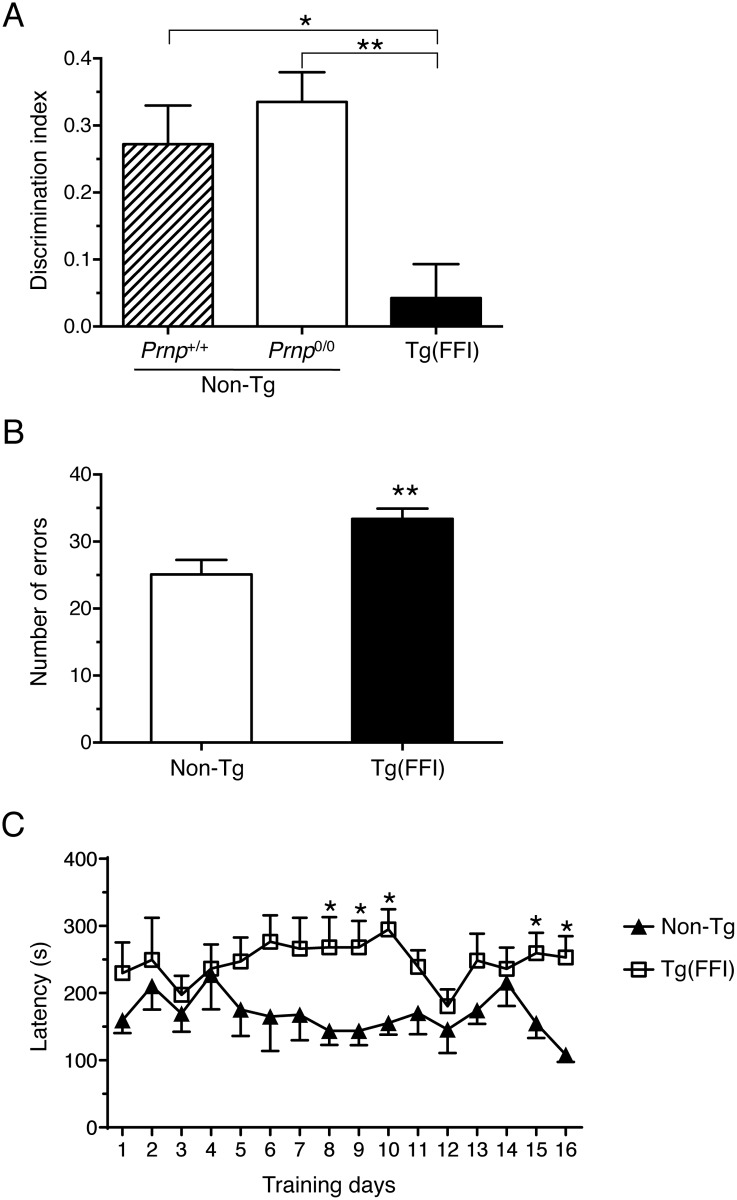
Tg(FFI) mice show recognition and spatial working memory impairment.(A) Performance in the novel object recognition task was expressed as a discrimination index (see Experimental Procedures). Histograms indicate the mean ± SEM of 10 non-Tg/Prnp
+/+, 10 non-Tg/Prnp
0/0, and 8 Tg(FFI-26+/-)/Prnp
0/0 aged 70 days; F2,25 = 8.3 p = 0.017 by one-way ANOVA; *p < 0.05, **p < 0.01, Tukey’s post hoc test. (B) Histograms represent the mean ± SEM of total errors in the eight-arm radial maze in the first eight trials during 16 days of training, by the same non-Tg/Prnp
0/0 and Tg(FFI-26+/-)/Prnp
0/0 mice used in A. t16 = 3.0; p = 0.009; **p < 0.01 by Student’s t test. (C) Values are the mean latency (± SEM) to complete the radial maze. F15,240 = 19; p = 0.03 by one-way ANOVA for repeated measures. *p < 0.05 by Student’s t test.